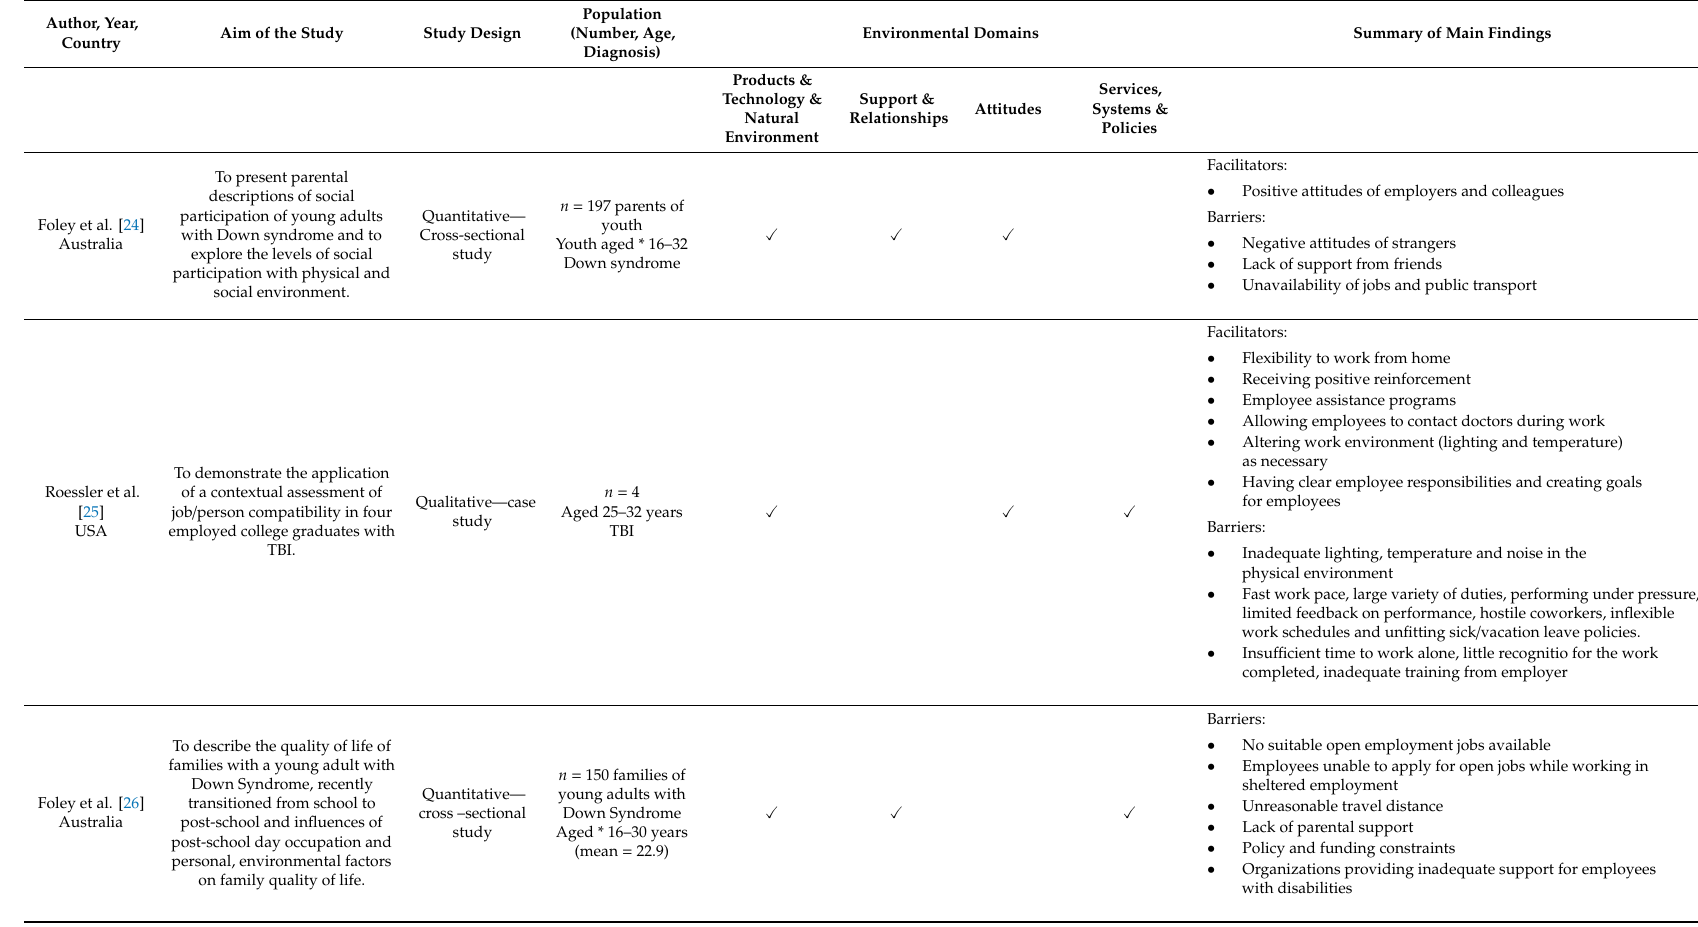
Table 2. The main findings of the individual articles ( n =